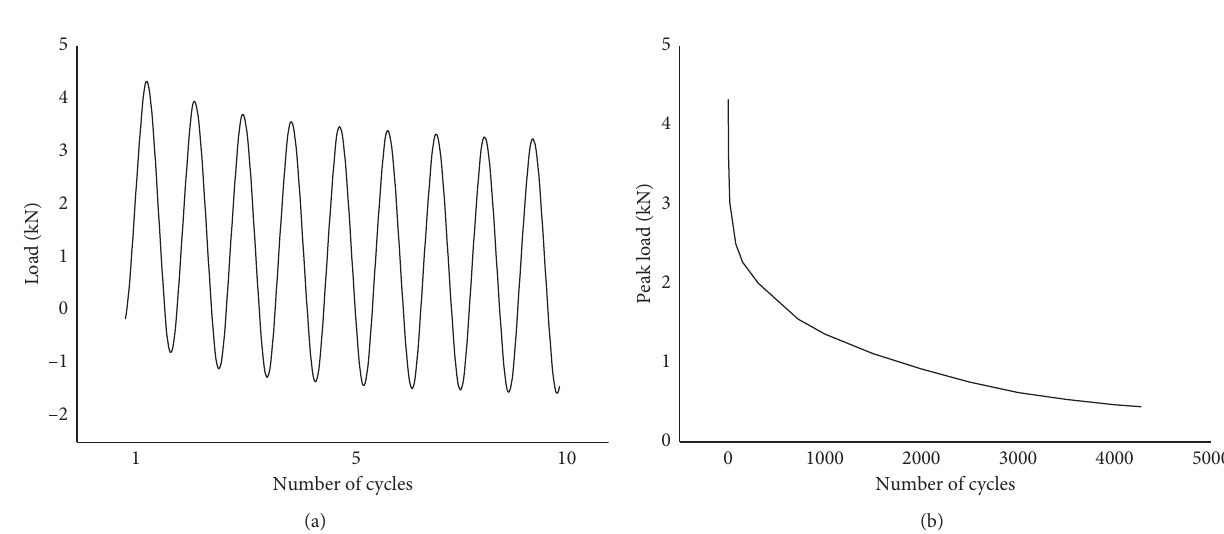
Figure 2: OT results data: (a) example of load cycles; (b) peak load reduction